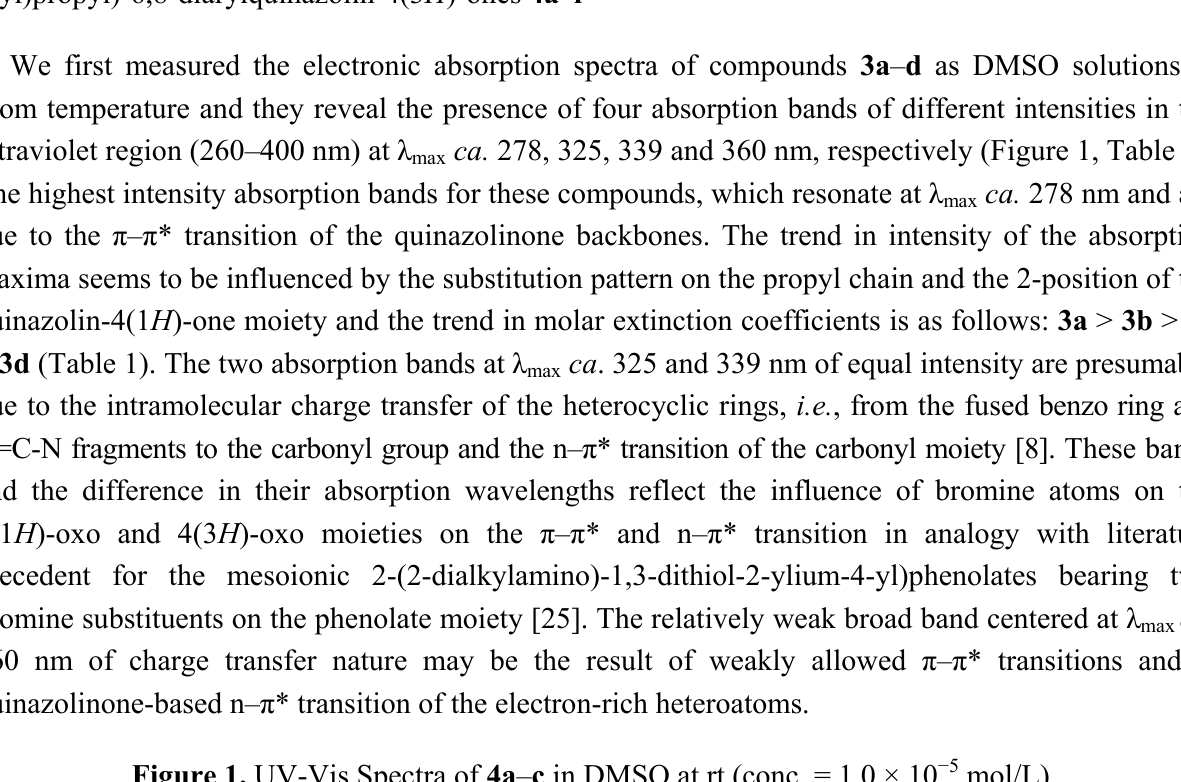
Figure 1. UV-Vis Spectra of 4a – c in DMSO at rt (conc. = 1.0 × 10 − 5 mol/L).